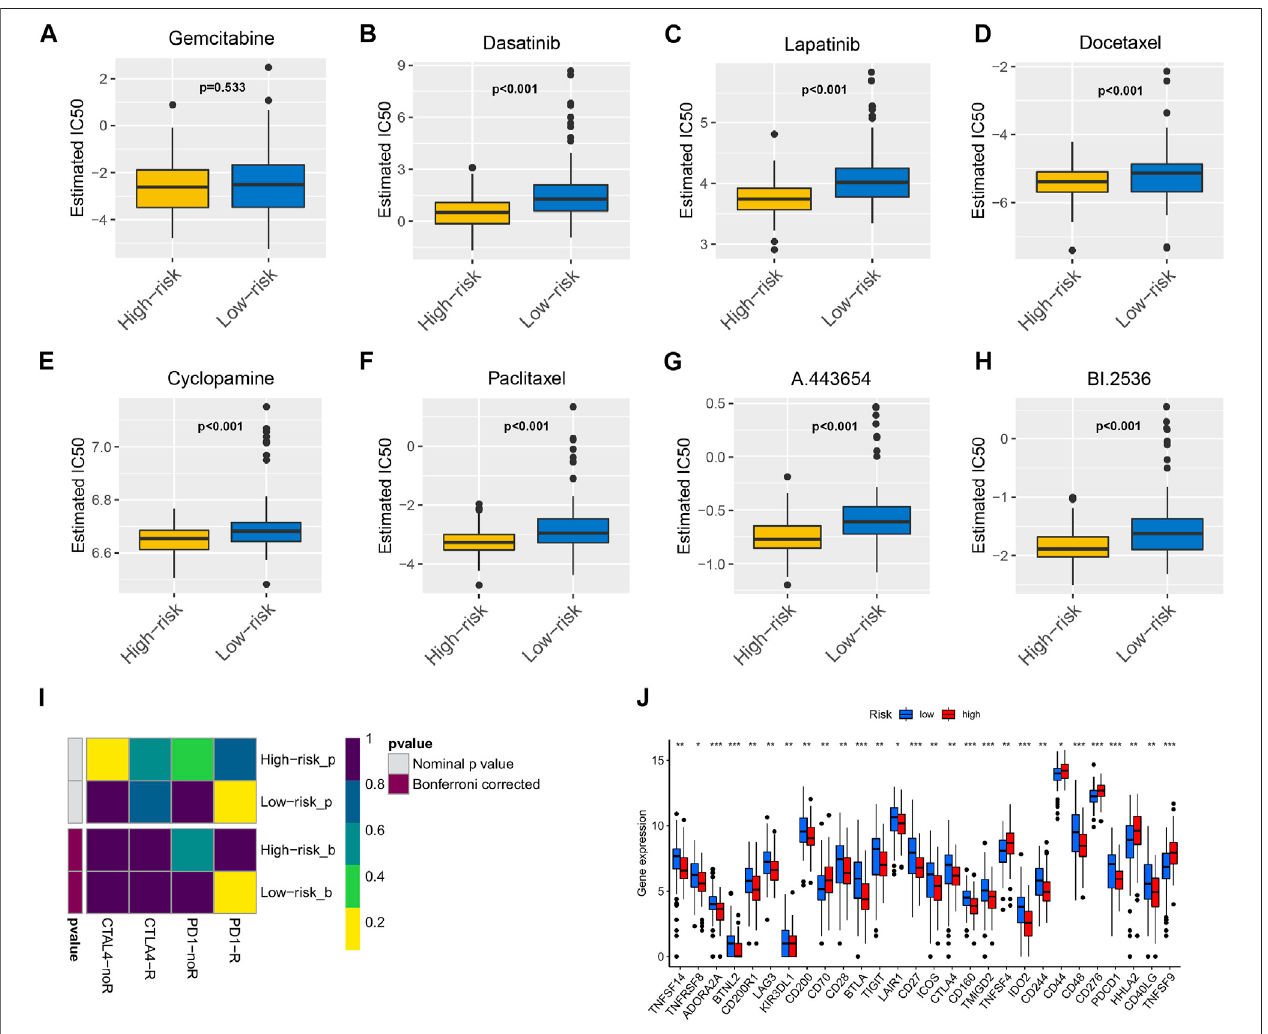
FIGURE 6 | The model acted as a potential predictor of chemosensitivity as high risk scores were related to a lower IC50 for chemotherapeutics such as doxorubicin, mitomycin, and cisplatin, whereas they were related to a higher IC50 for gemcitabine Box plots depicted the differences in the estimated IC50 levels of (A) Gemcitabine; (B) Dasatinib; (C) Lapatinib; (D) Docetaxel; (E) Cyclopamine; (F) Paclitaxel; (G) A.443654; (H) BI.2536 between the high and low risk score groups. The results illustrated that the group with low risk score was more likely to respond to immune checkpoint inhibitors (PD-1 and CTLA-4 inhibitors) than the group with high risk score (I) ; expression of immune checkpoints among high and low PAAD risk groups (J)